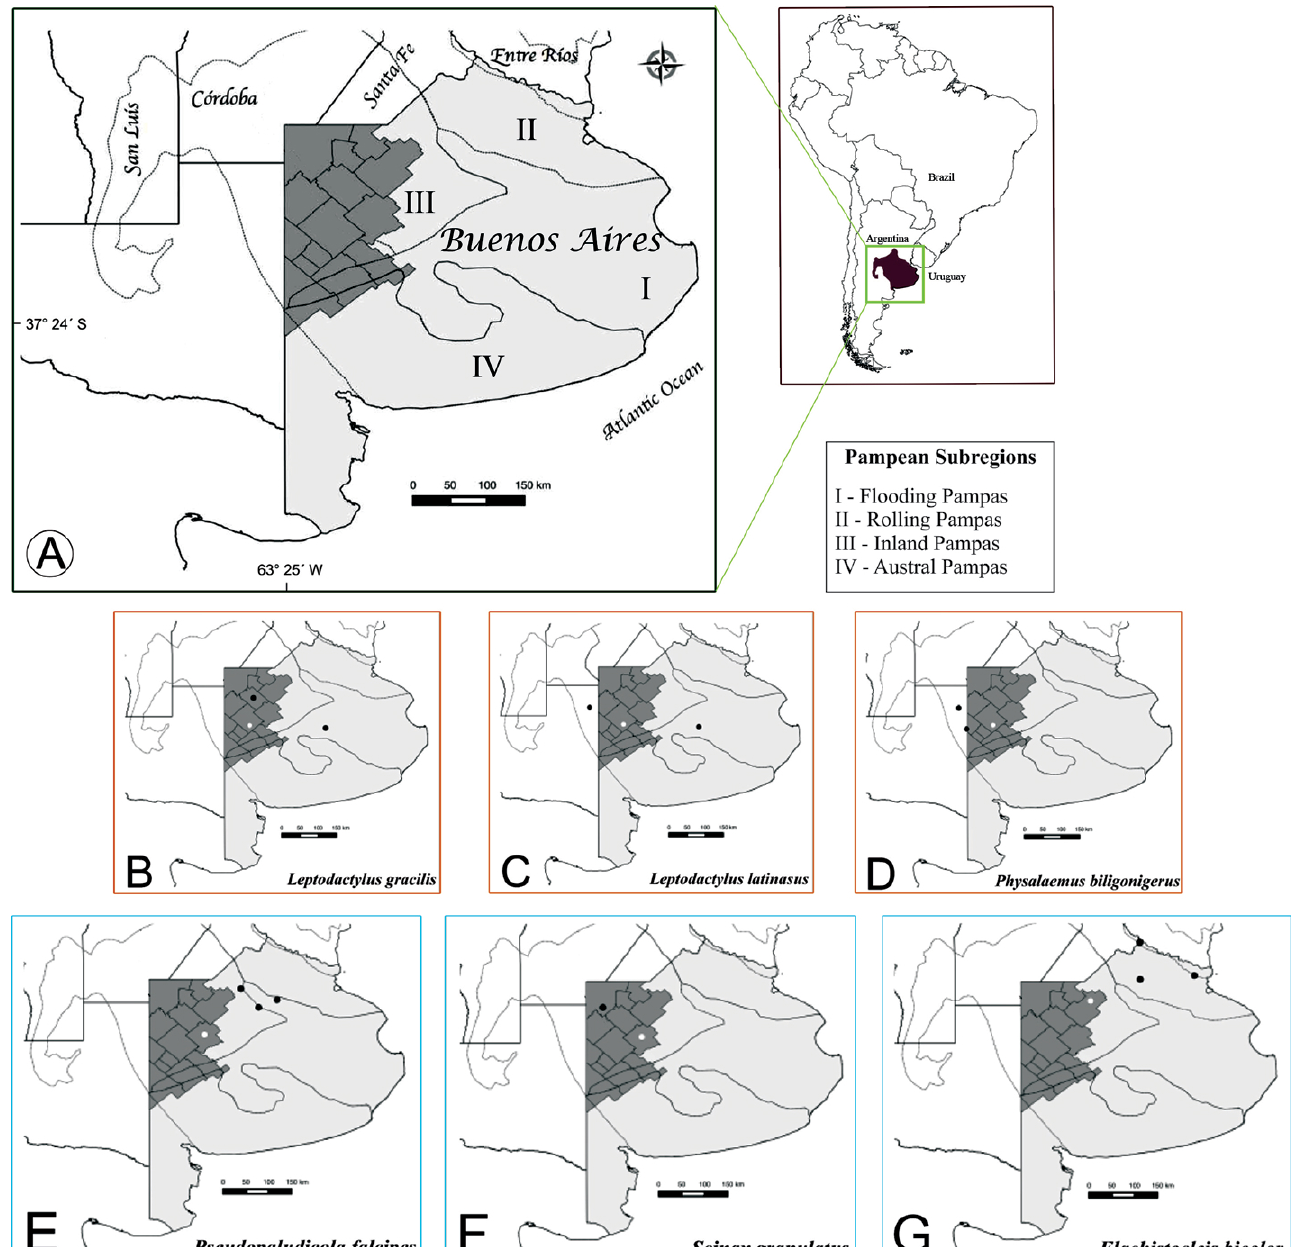
Figure 1. Maps of the study area, localities of species distribution limits in the study area and range extensions . A. Study area. Darker grey area repre- sents the departments (=Carlos Tejedor, Daireaux, Florentino Ameghino, General Villegas, Guaminí, Lincoln, Pehuajó, Pellegrini, Rivadavia, Salliqueló, Trenque Lauquen and Tres Lomas) in Buenos Aires province (light grey area) where the amphibian surveys were conducted between 2006 and 2015. B–D : Maps showing the species with distribution limits in the study area (orange border). E–G : Maps showing distributional extensions (blue border). New localities records are shown with black circles and nearest previous records are shown with grey